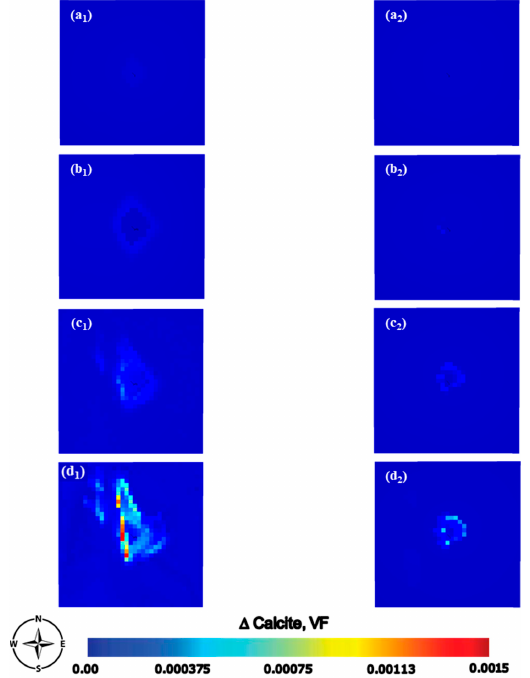
Figure A4. Plan view diagrams illustrating the simulated calcite volume fraction evolution for the base case from the arkosic layer top view ( a 1 , b 1 , c 1 , d 1 ) and homogenous case from the Upper Mt. Simon top view ( a 2 , b 2 , c 2 , d 2 ) at ( a ) 30 years, ( b ) 100 years, ( c ) 1000 years, and ( d ) 10,000 years. Each figure’s size is 35 km × 35 km (x, y).